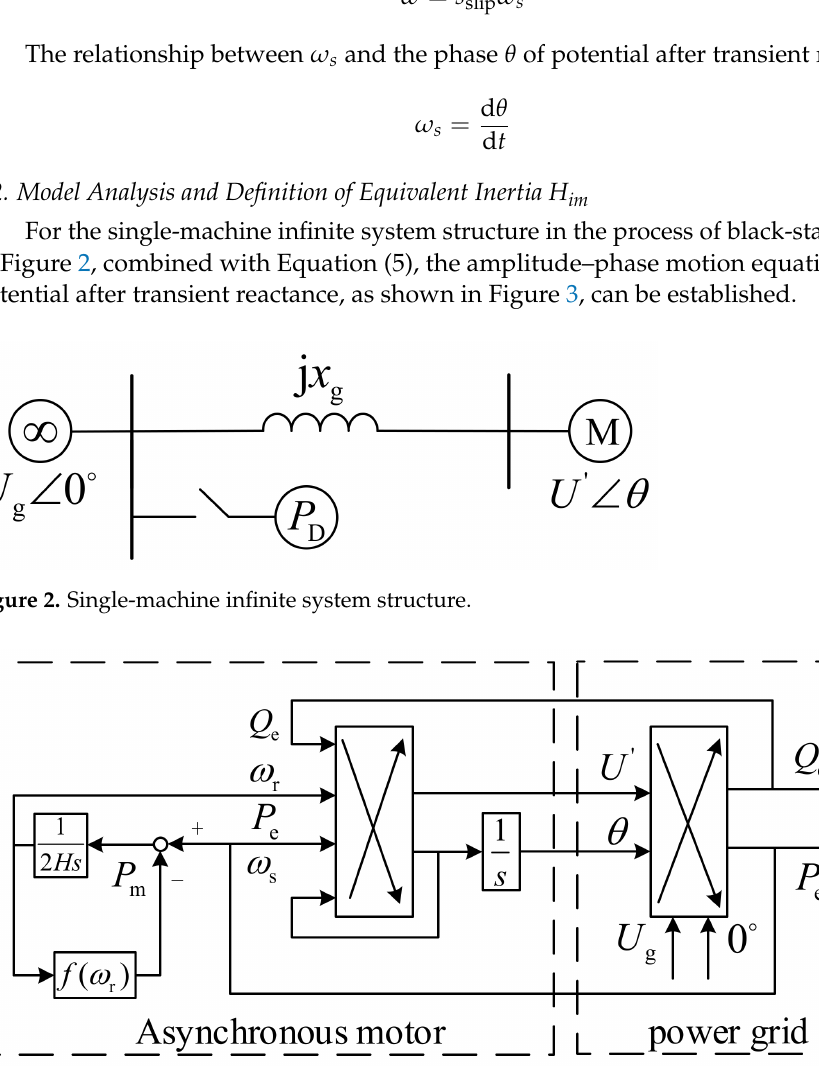
Figure 3. Amplitude–phase motion equation based on potential after transient